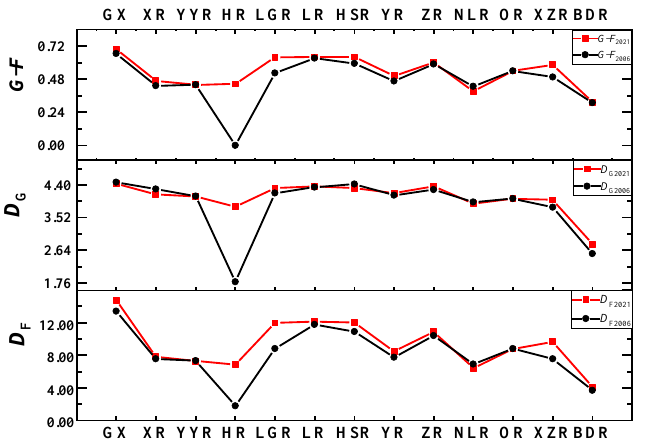
Figure 4. Comparison between 2006 and 2021 at the G , F , and G-F indices of 12 Sub−basin s in Guangxi. GX stands for the whole basins of Guangxi; Sub−basin codes are described in Table 1.